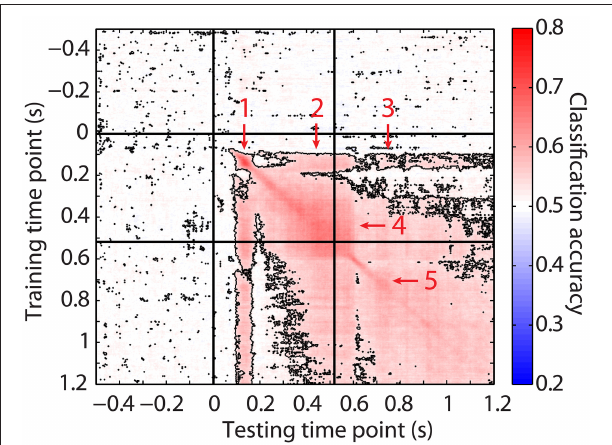
FIGURE 3 | Transfer learning results. Average accuracies obtained when classifiers were trained on the MEG signal at the time points on the y-axis, and tested on signals at the time points on the x-axis. Higher accuracies were marked as more red. Outlined accuracies were significantly higher than the averaged accuracies obtained from transfer learning on time points between 300 and 100ms before stimulus onset (FDR-corrected). The left vertical and upper horizontal line indicate stimulus onset. The right vertical and lower horizontal line indicate stimulus offset. Arrows indicate different blocks of transfer learning that are elaborated on in the